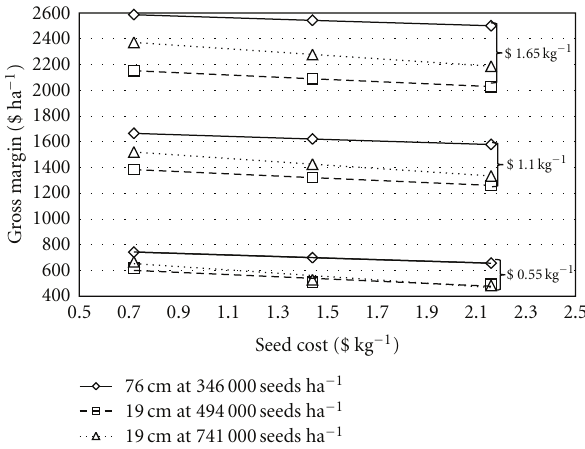
Figure 3: Gross margins for spring-interseeded winter rye at 67kg ha − 1 into wide- (76-cm) and narrow (19-cm) soybean rows for di ff erent soybean seed costs from $0.72 to $2.16 kg − 1 ($0.33 to $0.98 lb − 1 ) scenarios and returns for soybean ($0.55, $1.10, and $1.65 kg − 1 ) ($15 to $45 bu − 1